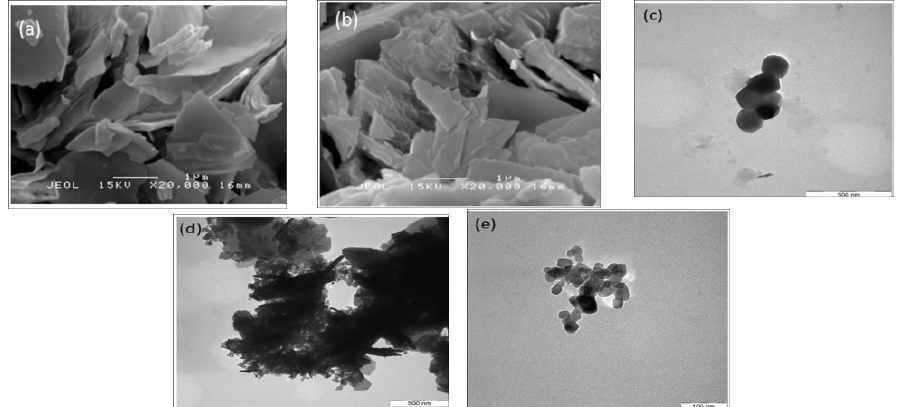
Figure 5. (a)SEM image of as-prepared BBN (b) SEM image of modified sample PTBA; (b) TEM image of BBN; (d) TEM image of PTBA and (e) shows the a magnified view of the dispersed TiO on PTBA 2